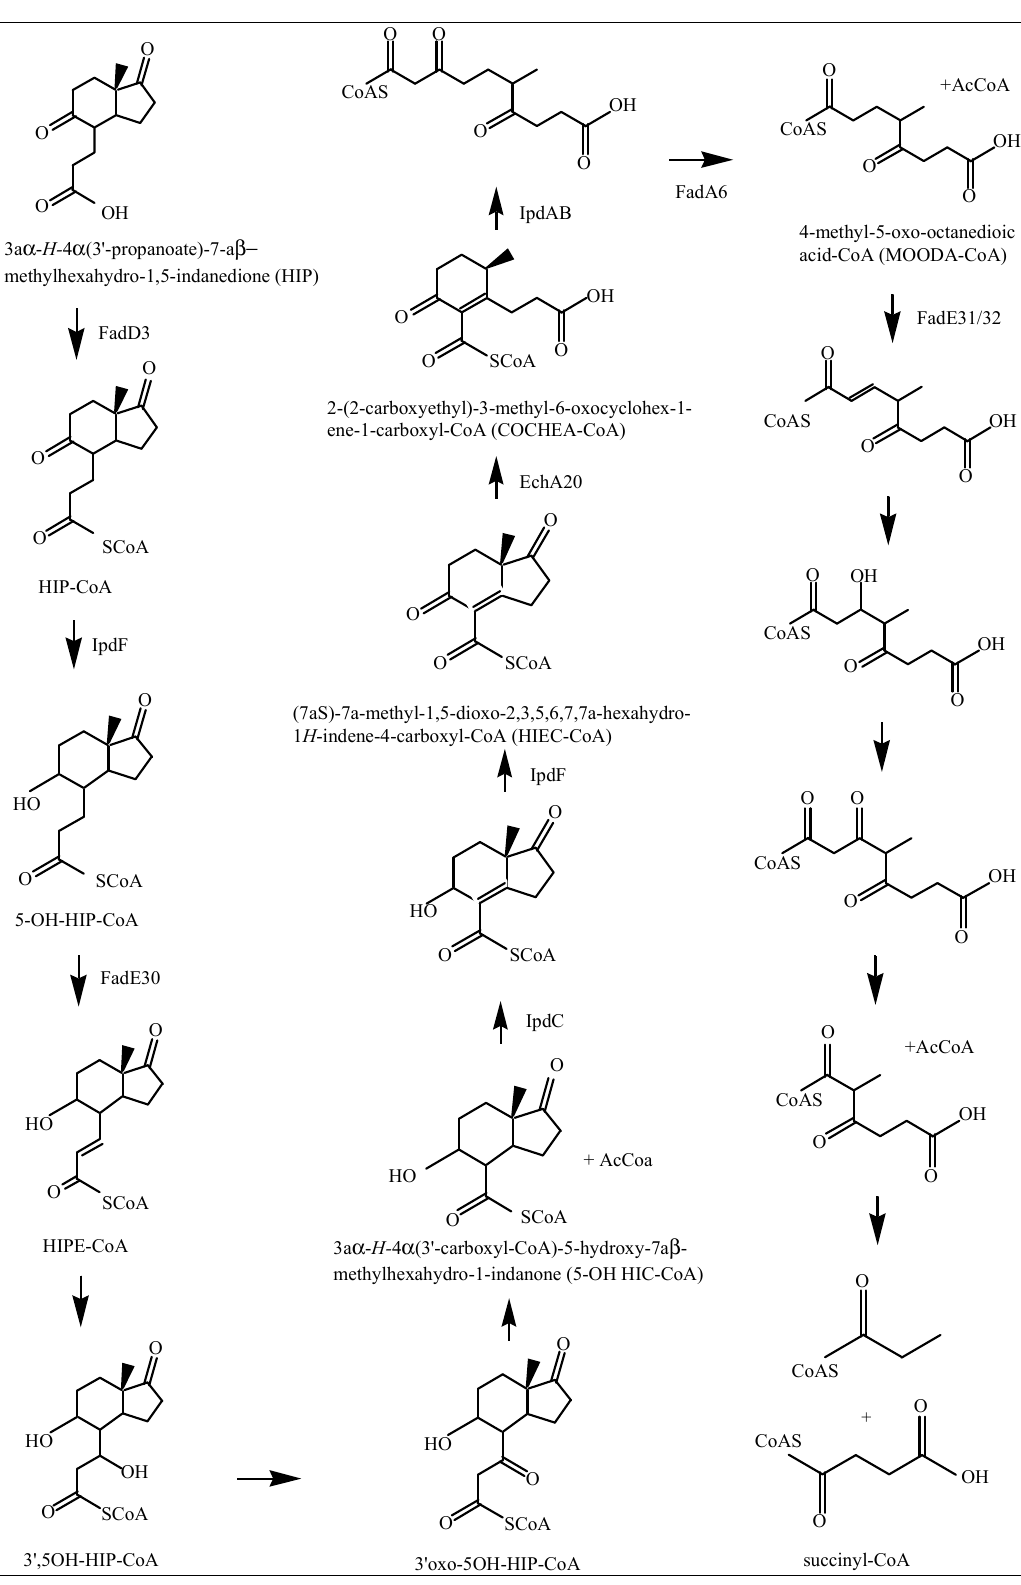
Figure 3. Proposed catabolic pathway of HIP [27]. If known, the enzymes involved in each reaction are depicted by arrows.